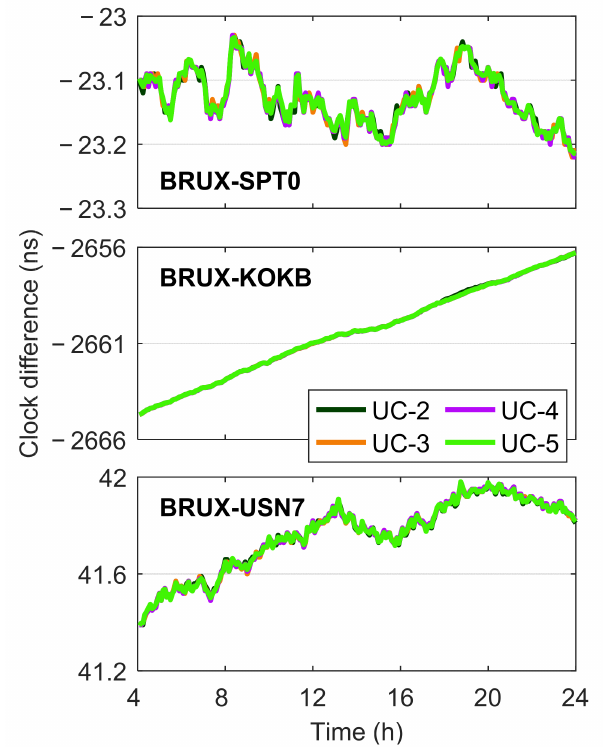
Figure 14. Three time links derived from Galileo dual-, triple-, four-, and five-frequency UC PPP solutions on DOY 248,